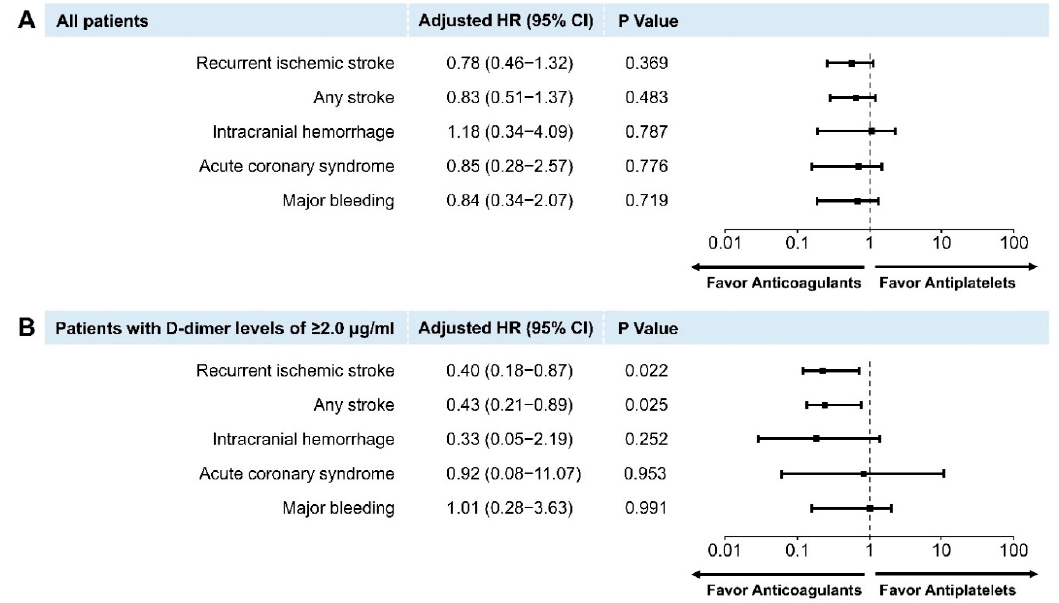
Figure 5. Cox proportional hazards regression analyses for primary and secondary outcomes. Adjusted hazard ratios for anticoagulant therapy compared with antiplatelet therapy in all patients ( A ) and patients with D-dimer levels of ≥ 2.0 μ g/mL ( B ).